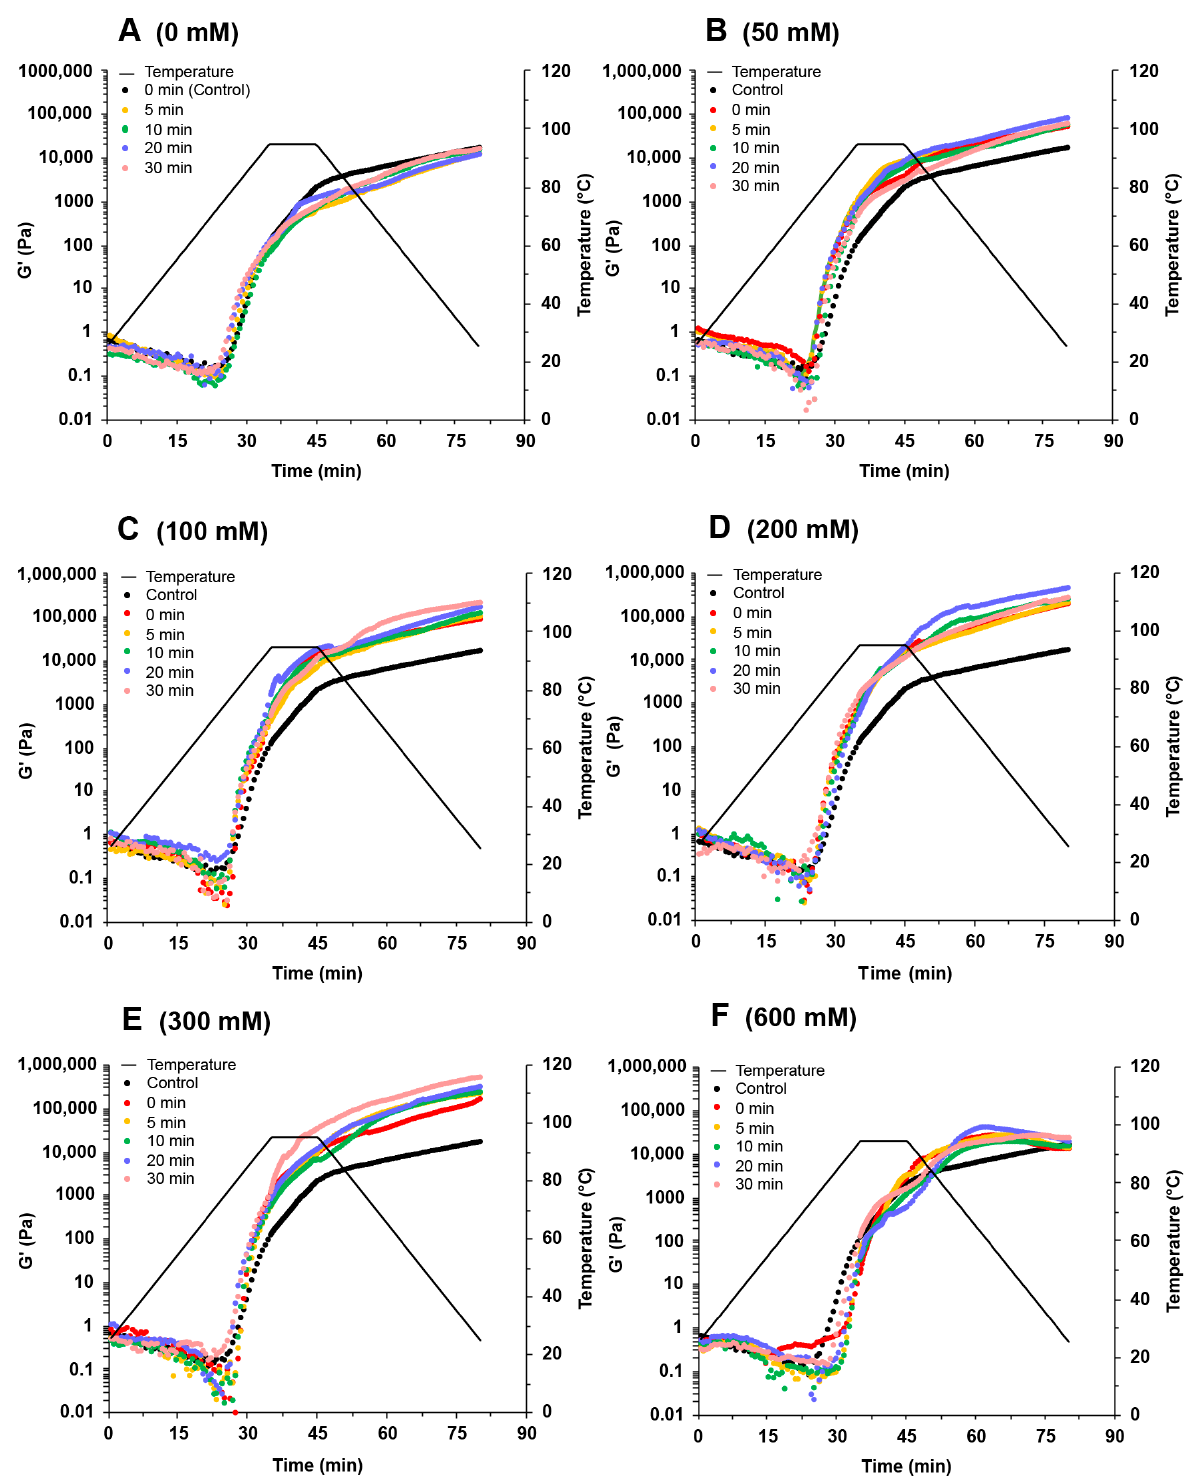
Figure 5 . Change in storage modules (G ′ ) during the heating–cooling cycle of soy protein isolate treated by varying ultrasound processing times (0, 5, 10, 20, and 30 min) at different NaCl concentra- tions at 0 mM ( A ), 50 mM ( B ), 100 mM ( C ), 200 mM ( D ), 300 mM ( E ), and 600 mM ( F ). In the absence of NaCl, the ultrasound treatment had little influence on the G ′ values of SPI gels (Figure 5A). The G ′ values increased with the addition of NaCl up to 300 mM and decreased at 600 mM NaCl (Figure 5B–F). Adding NaCl at low concentrations could shield the surface charge of proteins and reduce intermolecular repulsion, facilitating gel formation. Adding more NaCl could inhibit the unfolding of the proteins and affect the gel network formation [31]. In the presence of NaCl, the G ′ values increased with increas- ing ultrasound time, reaching a maximum when the sample was treated with 300 mM NaCl and 30 min ultrasound (Figure 5E). Ultrasound treatment increased the number of smaller protein particles (Figure 1), which could strongly aggregate with each other dur- ing the heating process, forming a more robust gel network [32]. Wang et al. [33] reported that the increase in surface hydrophobicity could also promote the enhancement of hy- drophobic interaction between proteins so that protein gels form a denser gel network, which was conducive to the improvement of gel properties. In addition, good protein sol- ubility provides better gel properties [2]. The increase in protein solubility facilitated the gel network formation and improved the protein gel properties. Therefore, the enhanced SPI gels treated with NaCl promoted protein aggregation by shielding the protein surface charge, while ultrasound reduced the aggregate size and increased the protein solubility and surface hydrophobicity.